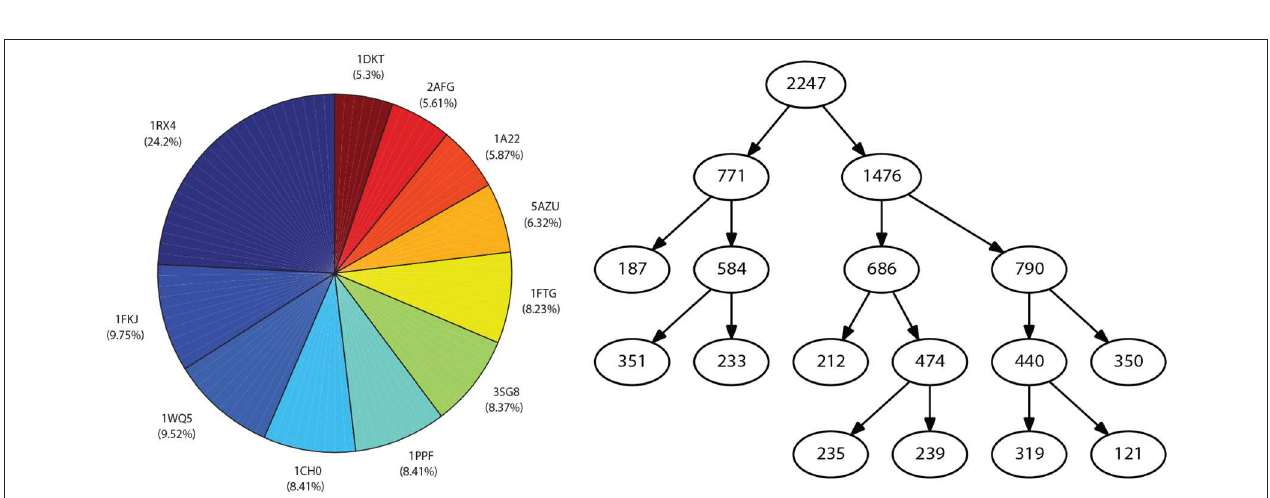
FIGURE 3 | Histograms of performance metrics obtained in the exploration stage by the RV-Clustering library for the protein location in an E. coli dataset. The highest values were obtained by methods based on Bagging or Boosting algorithms, accounting for the non-linearity of the dataset.